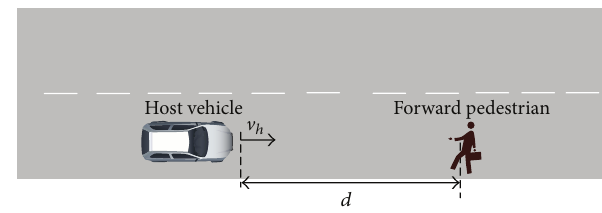
Figure 2: Pedestrian appears in front of the host